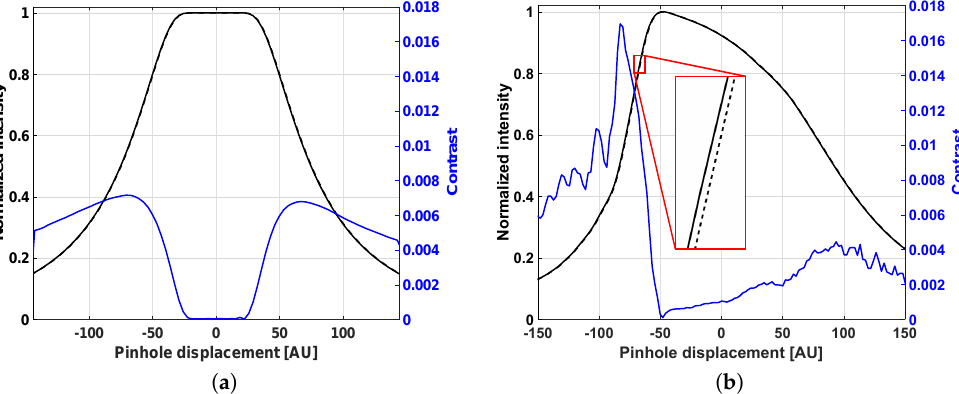
Figure 3. Simulations with an aperture size of 10 AU. ( a ) Simulation with ideal lenses. ( b ) Simulation with a real lens and a magnification of the intensity difference from the top and bottom of the